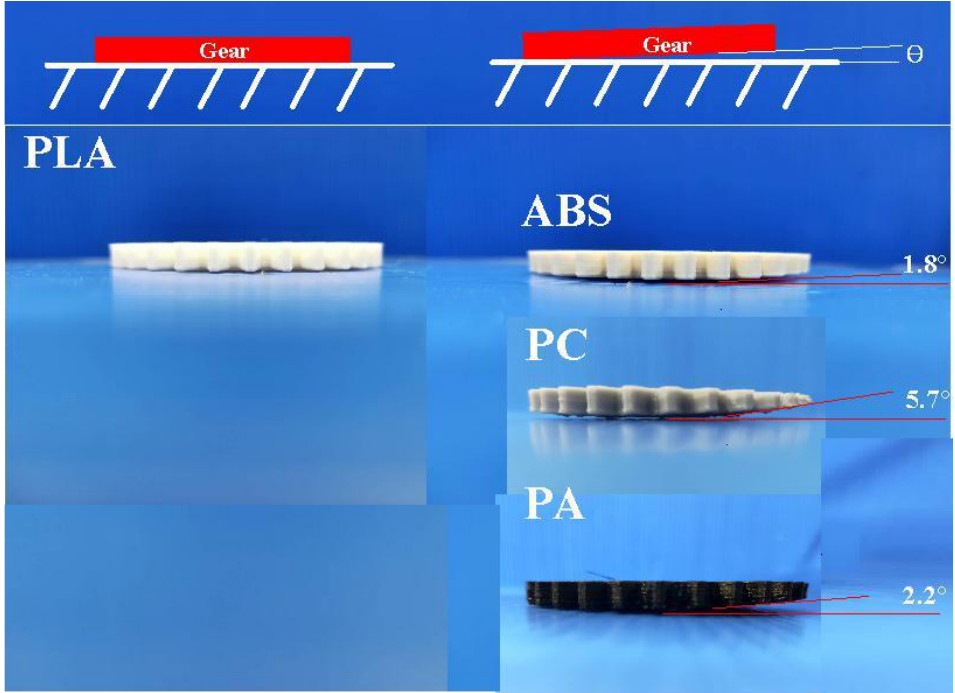
Figure 16. Spur gears printed with PLA, ABS, PC, and PA filaments.